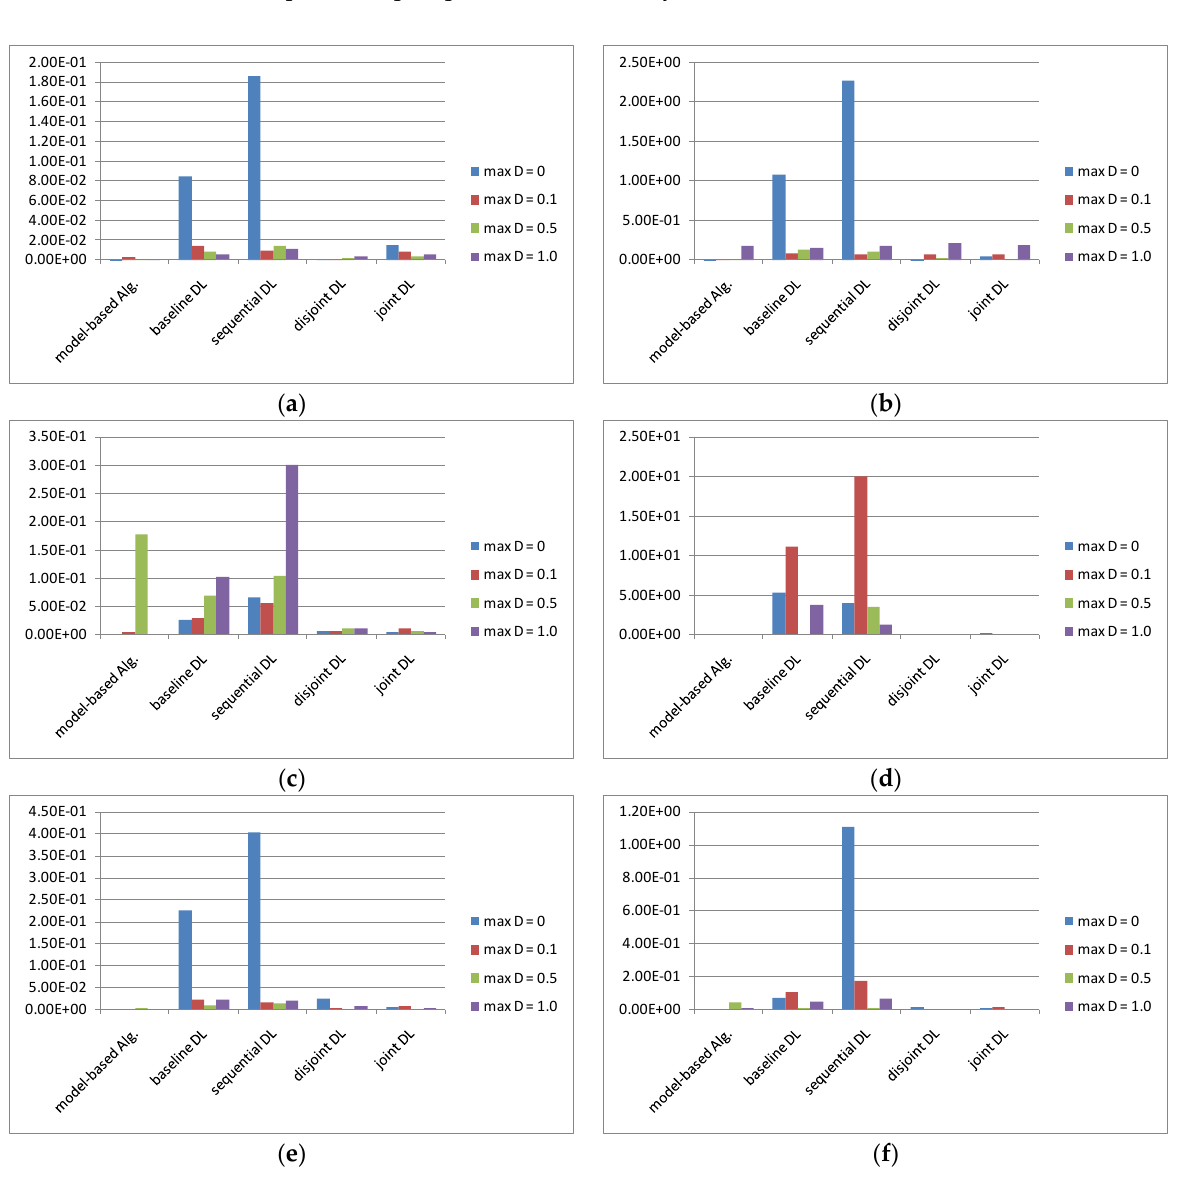
Table 4. Average mean square of displacement from the leader position over all simulation cases for different train data .